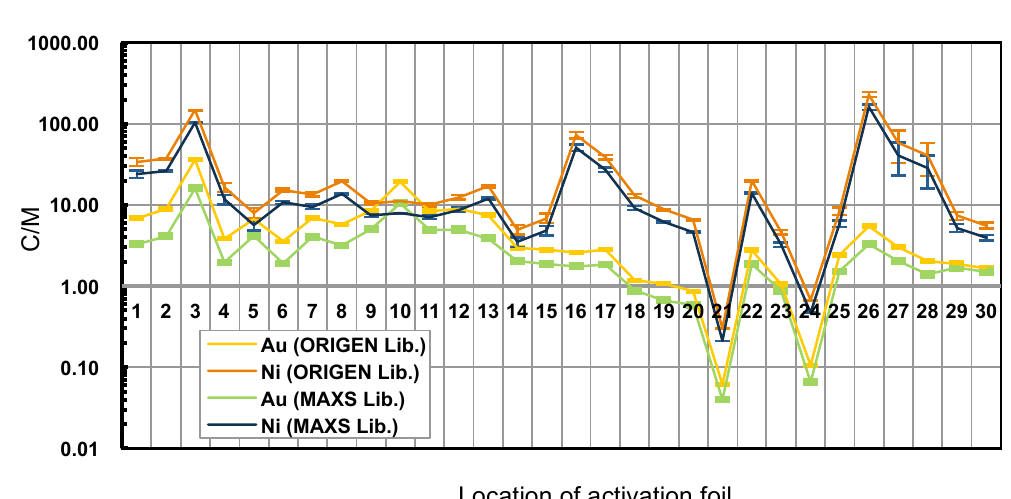
Figure 5 Comparisons between calculated and measured radioactiveities (C/M) with ORIGEN library and with MAXS library at each foil